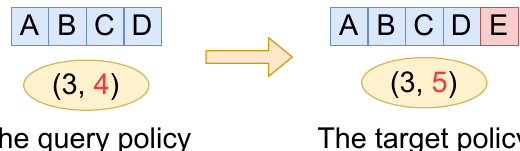
Figure 3. An example of the first